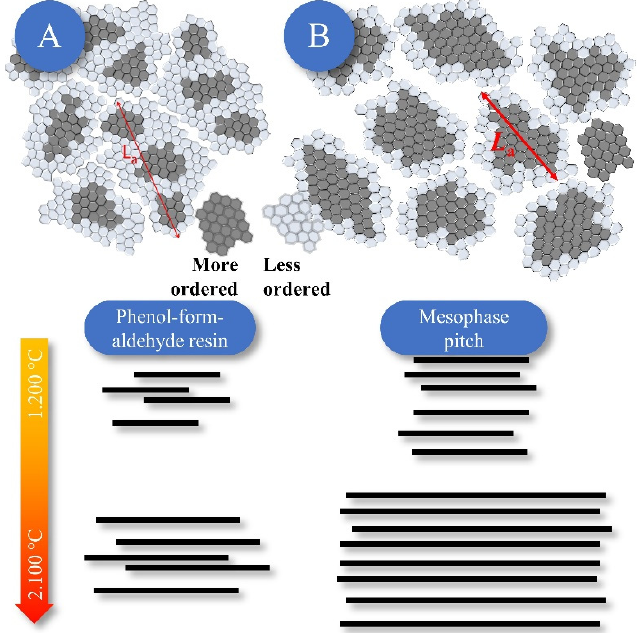
Figure 15. New insights into the microstructure of non-graphitic carbon: Compared to prior studies on the same materials [43] ( A ), the present analysis ( B ) suggests smaller, but highly ordered graphene-layers. Reprinted and adapted with permission from Ref. [43]. Copyright 2019 American Chemical Society.